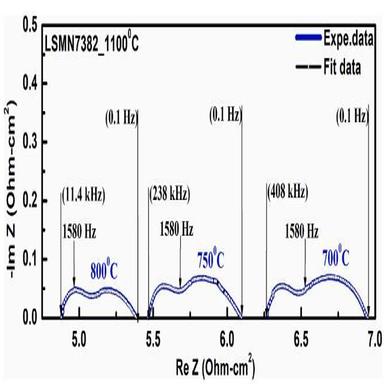
Nyquist plot of LSMN7382, cathode with LSGMN10 as electrolyte in the range of 700–800 ◦C with cell sintered at 1100 ◦C.